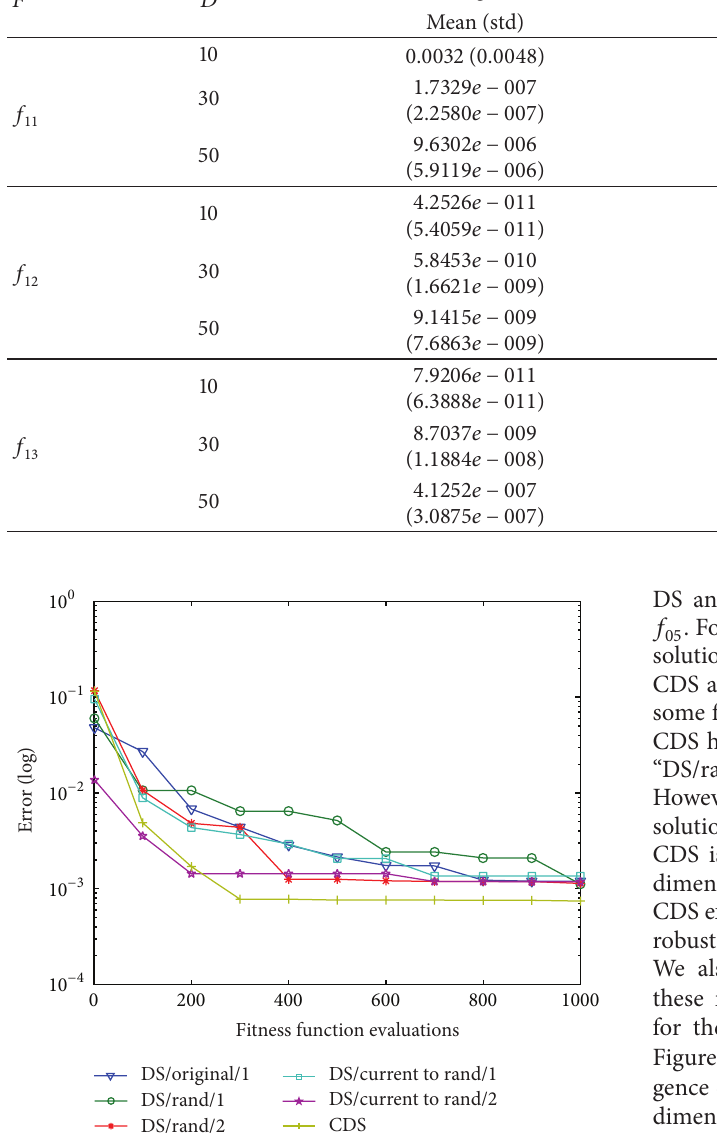
Figure 13: Comparison of performance of six algorithms for minimization of 𝑓 15 with fixed